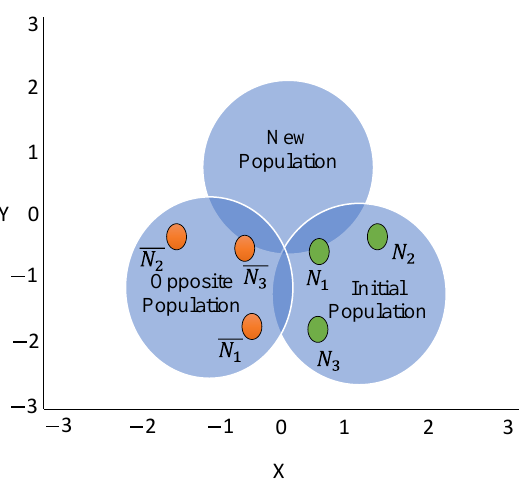
Figure 1. Illustration of opposition-based learning mechanism [2].